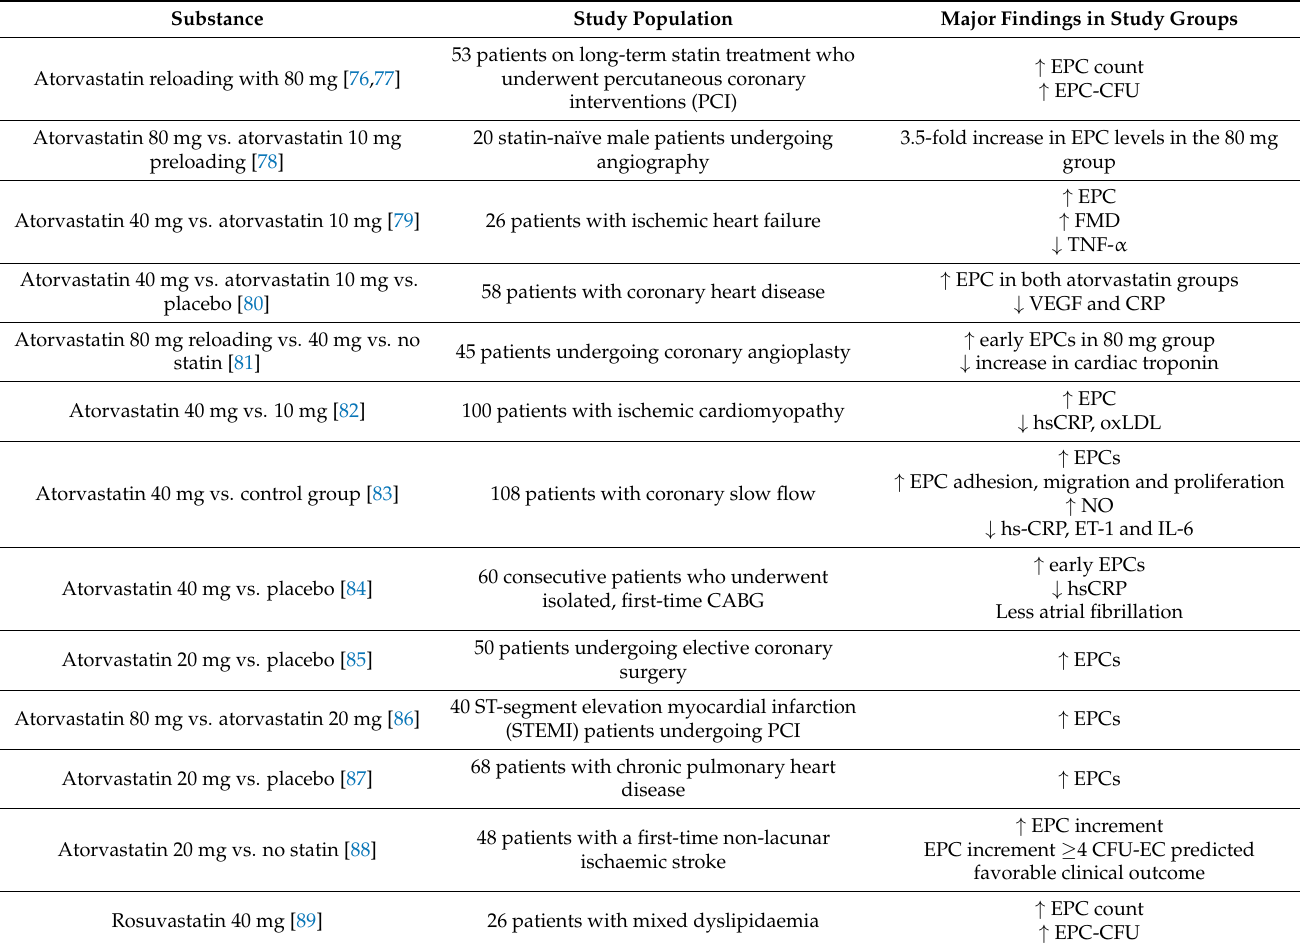
Table 1. Summary of clinical trials on various antilipemic drugs affecting EPC